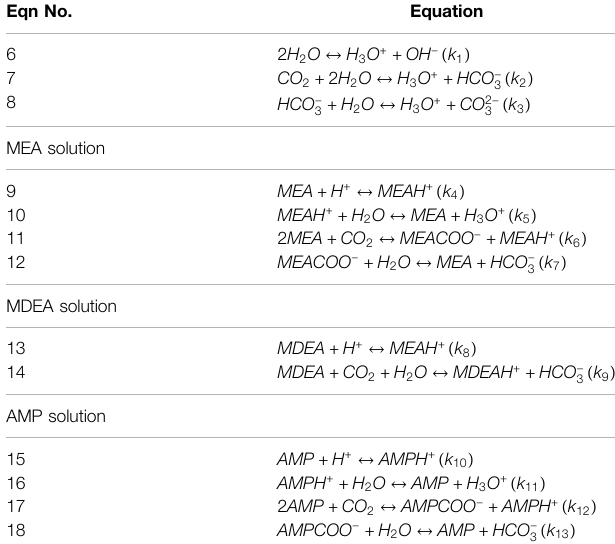
TABLE 1 | Mechanism of CO 2 capture in aqueous amine solution. Eqn